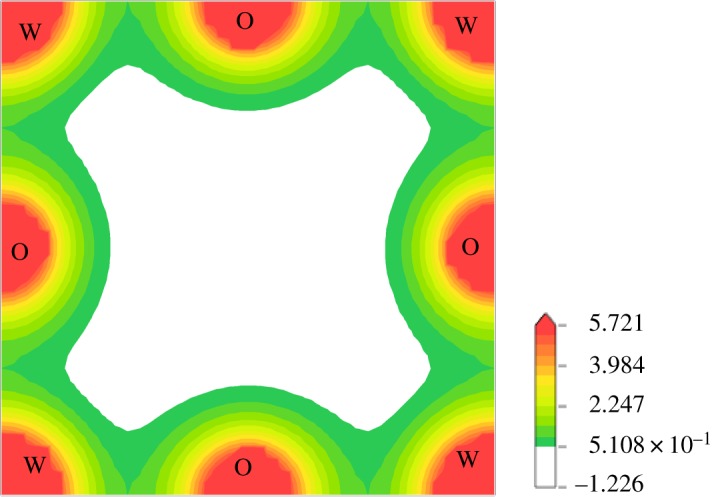
Charge densities of cubic WO3.